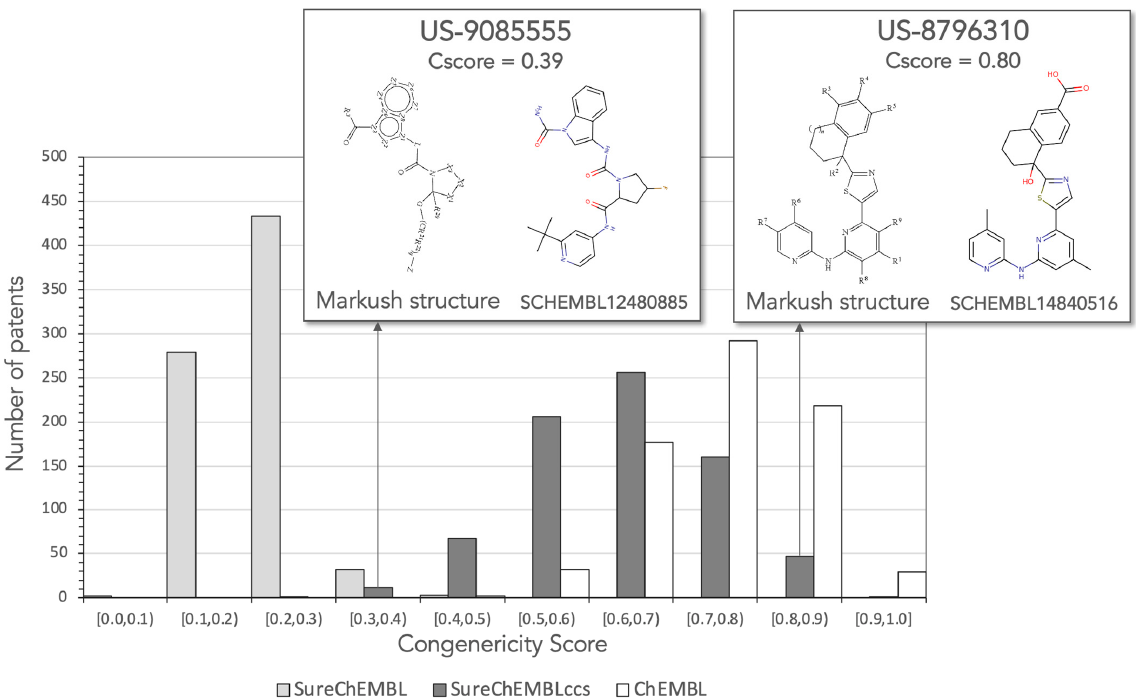
Figure 7. Congenericity Score (CScore) distributions for the same 750 patents in SureChEMBL, SureChEMBLccs and ChEMBL.